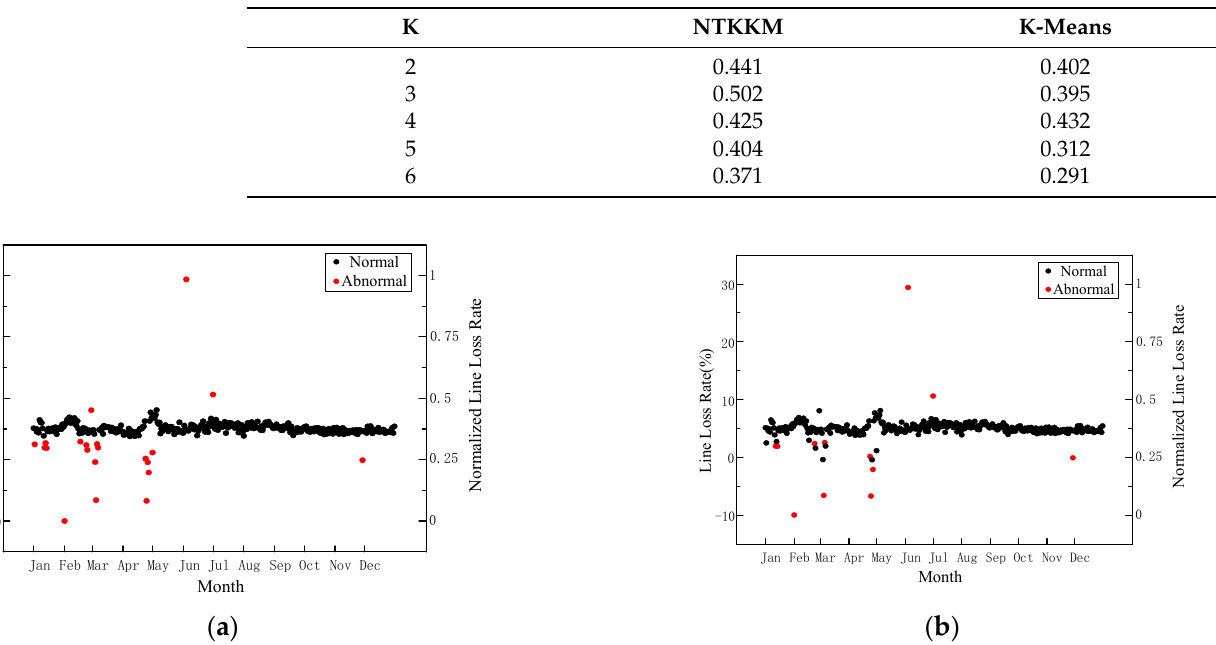
Figure 5. Clustering result of historical line loss rate: ( a ) NTKKM clustering results. ( b ) Traditional K ‐ means clustering results.